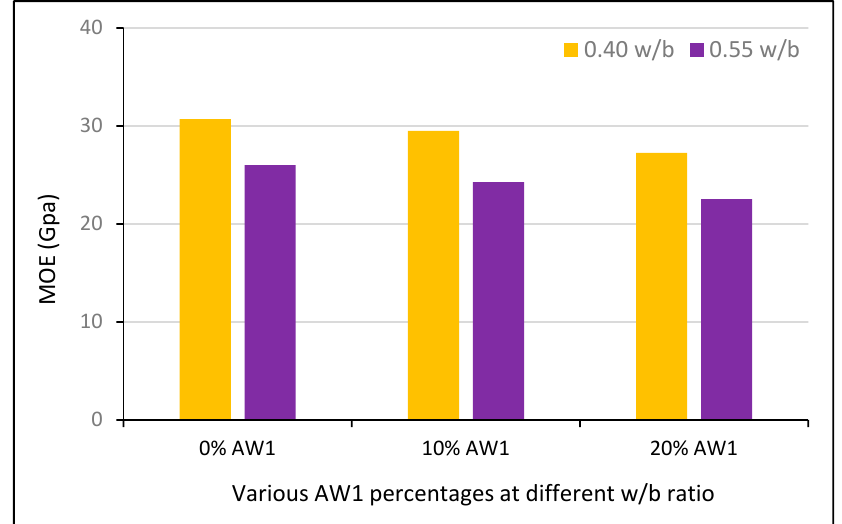
Figure 12. Elastic modulus of RHA-modified concrete at various w/b ratios [233].